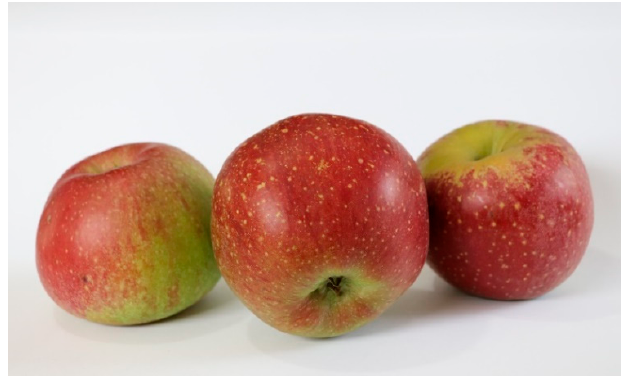
Figure 1. ‘Majda’ apples.